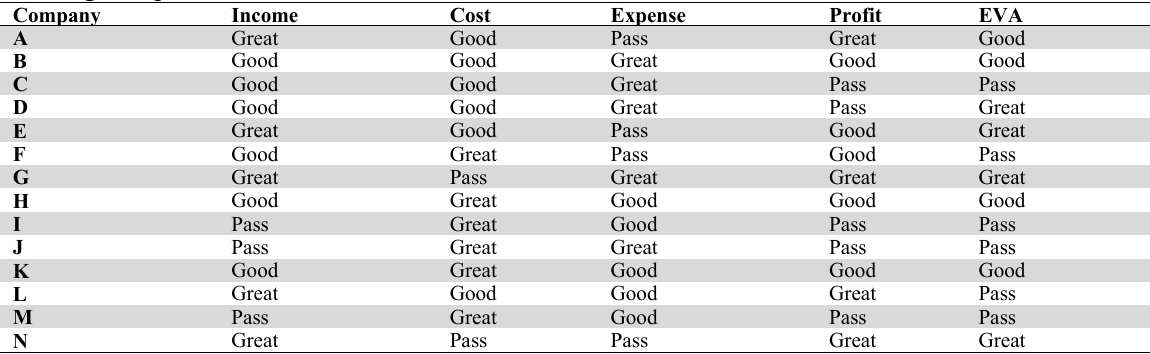
Training Samples